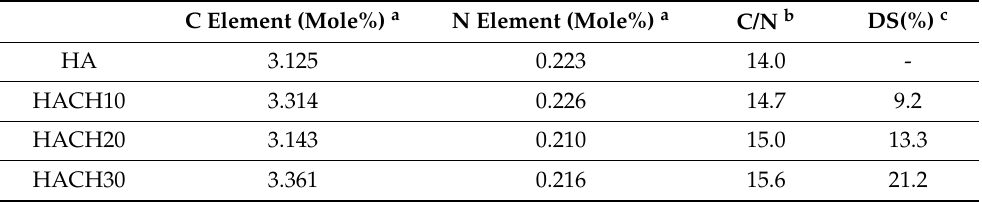
Table 1. C/N ratio and DS% of the cholesterol on HA. C Element (Mole%) a